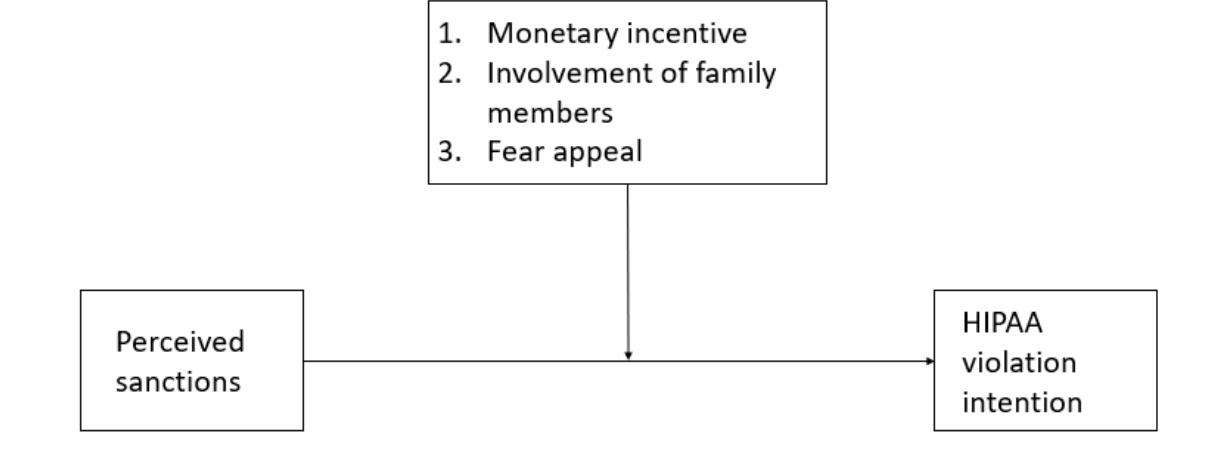
Figure 2. The conceptual model. HIPAA: Health Insurance Portability and Accountability